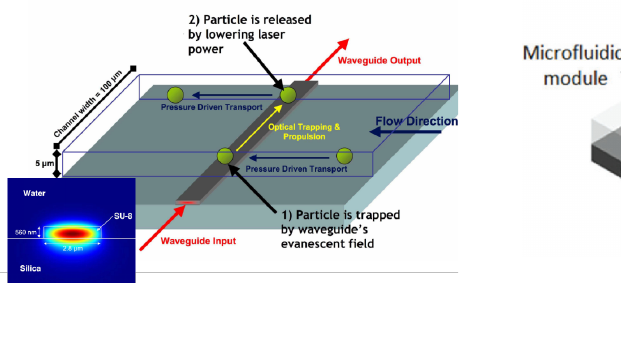
Figure 29. ( a ) SU-8 fabricated waveguides for trapping platform. Adapted with permission from [78]. © (2007) The Optical Society. ( b ) SU-8 fabricated waveguides for sensing platform. Reprinted with permission from [152]. © (2018) The Optical